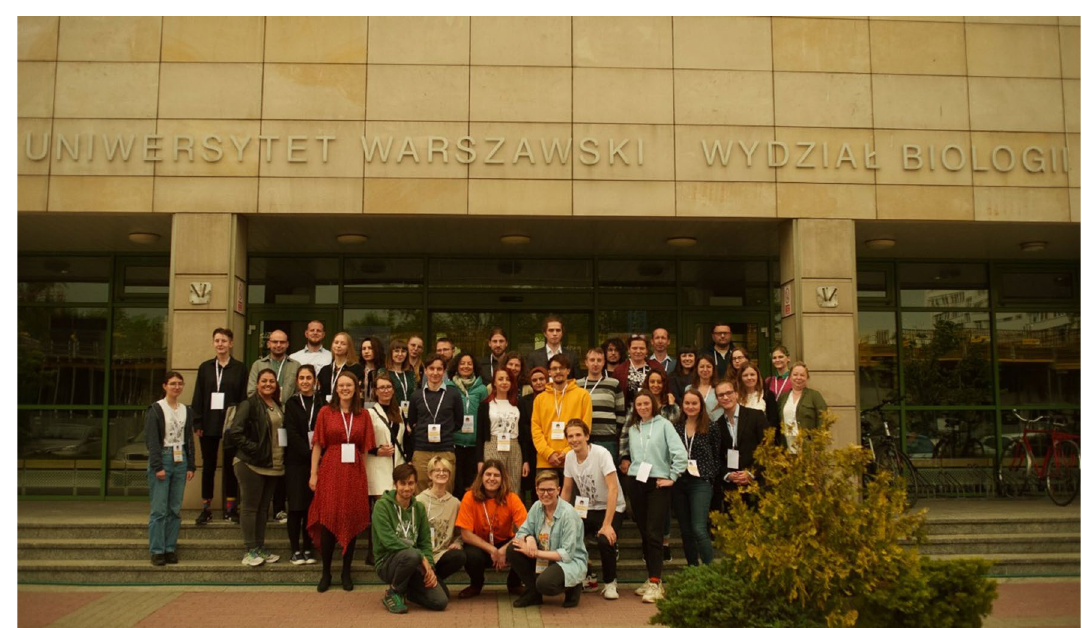
Fig. 14 MycoRiseUP! 2022 group picture taken during the conference. Photo : Karolina